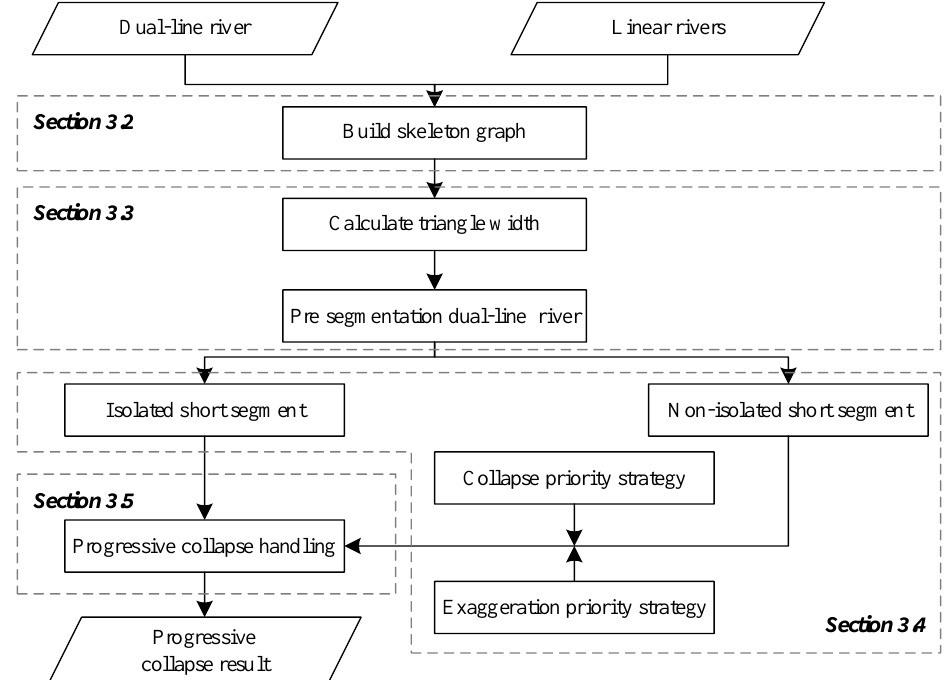
Figure 1. Flow of progressive collapse of dual-line rivers based on river segmentation considering cartographic generalization rules.